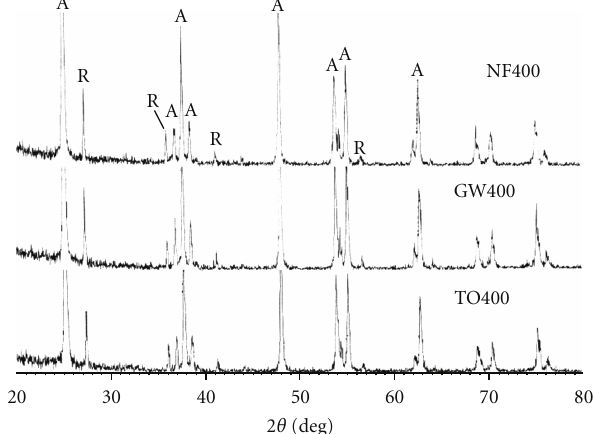
Figure 1: XRD patterns of the nitrogen-doped and nondoped TiO 2 (sample ground with 1.40 g of NH 4 F (NF400), ground with water (WG400), and the raw TiO 2 (TO400); all three samples were calcined at 400 ◦ C for 2h; A: anatase, R: rutile).